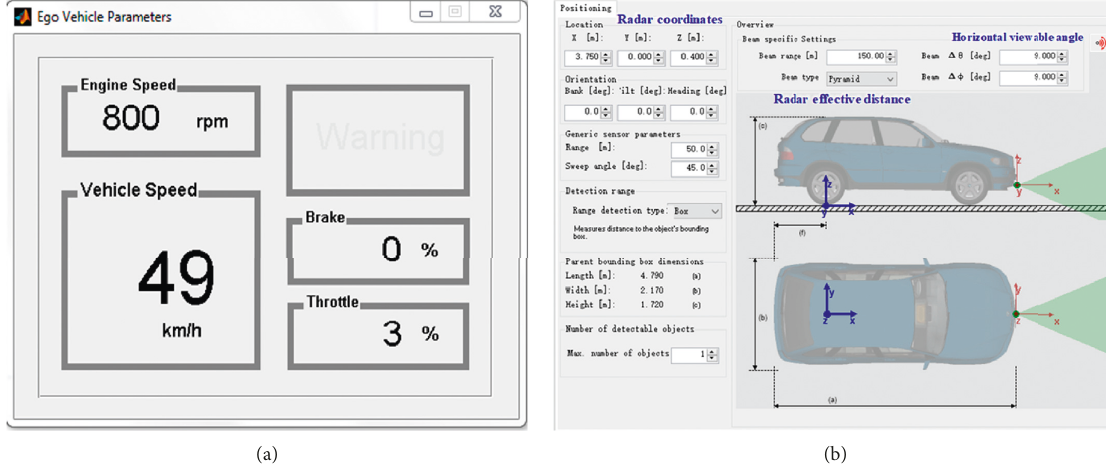
Figure 8: Simulation of dynamic visualization: (a) braking parameters; (b) vehicle-borne radar parameters.